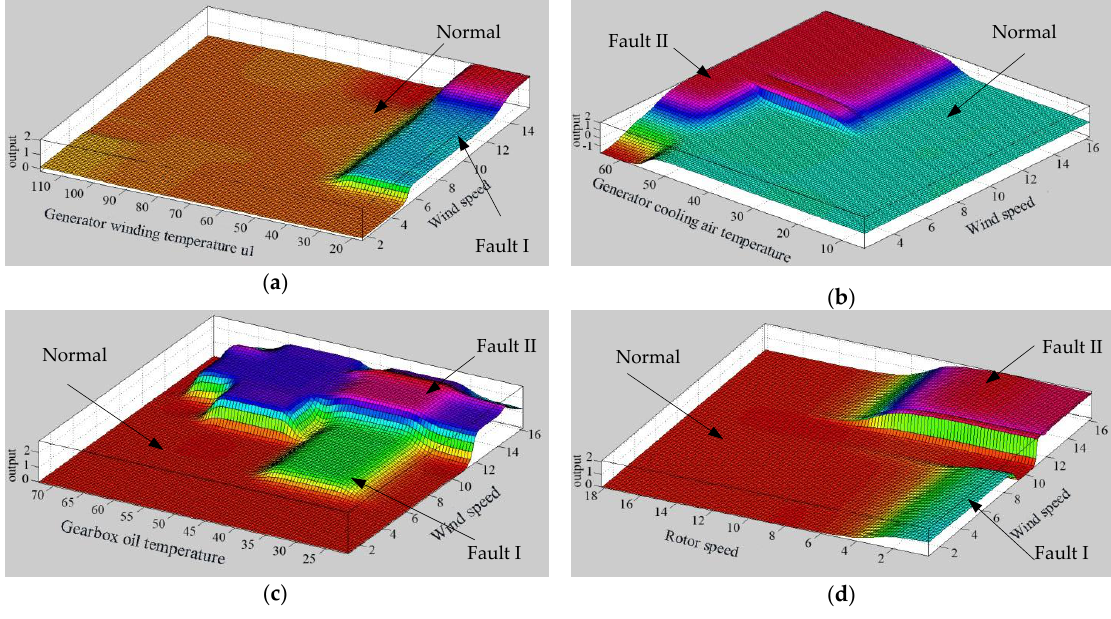
Figure 9. Early warning sub model: ( a ) wind speed vs. generator winding temperature u1; ( b ) wind speed vs. generator cooling air temperature; ( c ) wind speed vs. gearbox oil temperature; and ( d ) wind speed vs. rotor